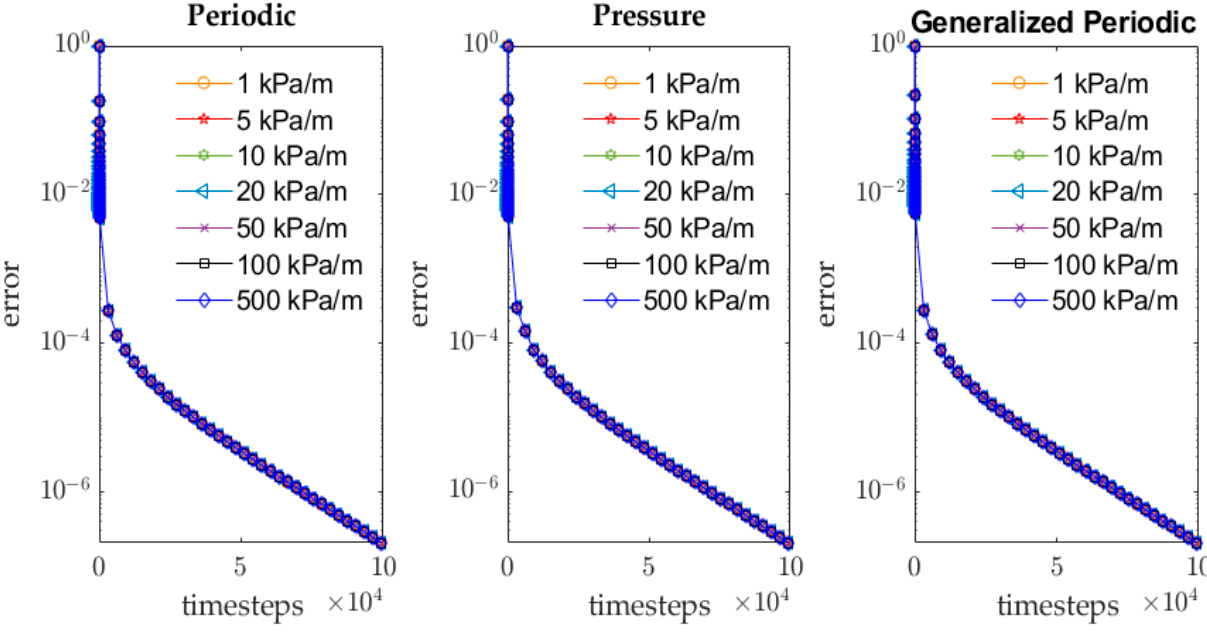
Figure 13. Convergence behavior in domain D1.